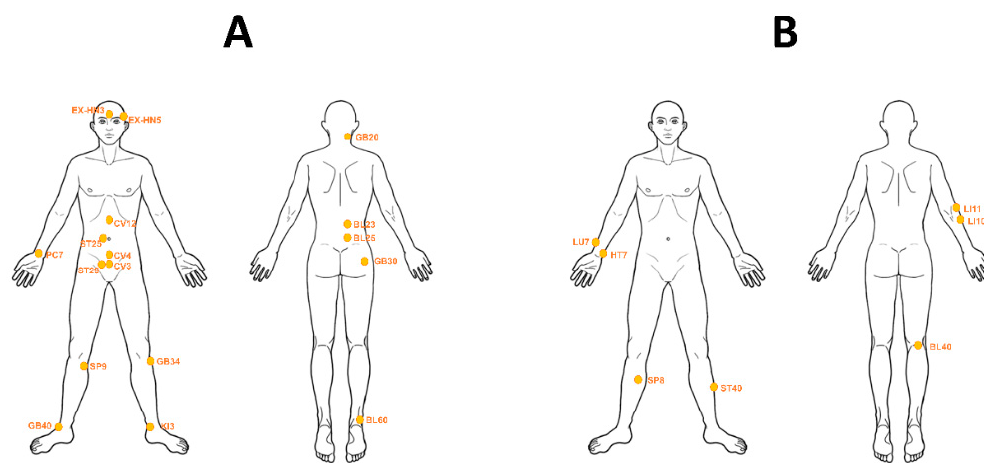
Figure 5. Two patterns of acupoint indications. ( A ) Type 1 includes acupoints with regional indications distributed in the head, back, abdomen, and ankle ( n = 17; BL23, BL25, BL60, CV3, CV4, CV12, EX-HN3, EX-HN5, GB20, GB30, GB34, GB40, KI3, PC7, SP9, ST25, ST29). ( B ) Type 2 includes acupoints with distal indications distributed in the upper/lower limbs ( n = 7; BL40, HT7, LI10, LI11, LU7, SP8, ST40).